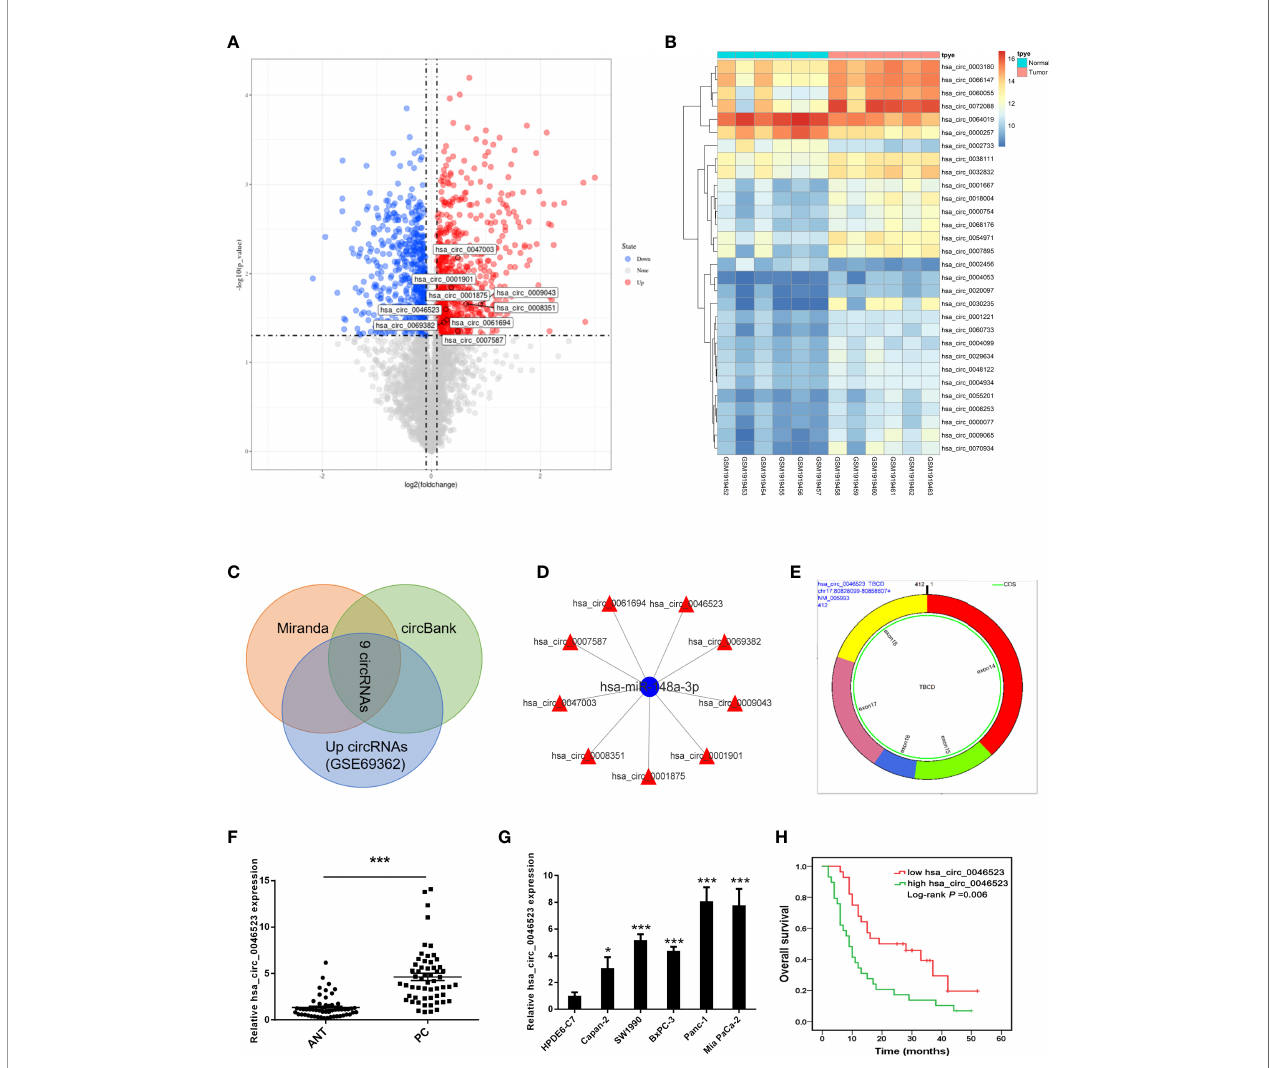
FIGURE 1 | CircRNA pro fi ling and the expression of hsa_circ_0046523 in PC. (A) Volcano map of differentially expressed circRNAs in PC tissues. (B) Cluster analysis of the expression levels of the top 30 upregulated circRNAs in PC tissues. (C) Predicted circRNAs with binding sites to miR-148a-3p from Miranda software andcircBank database. (D) Network construction diagram ofmiR-148a-3p and circRNAs. (E) Basiccharacteristics of hsa_circ_0046523. (F) Relative hsa_circ_0046523 expression in 57 pairs ofPC and ANT specimens. (G) Relative hsa_circ_0046523 expression in fi vePC celllines (Capan-2, SW1990, BxPC-3, Panc-1 and Mia Paca-2)and the normalHPDE6-C7 cellline. (H) Kaplan – Meier analysisof the correlation between hsa_circ_0046523 expression and overallsurvival of PC patients. Data were expressed as means± SDofthree independentexperiments. * P < 0.05, *** P <